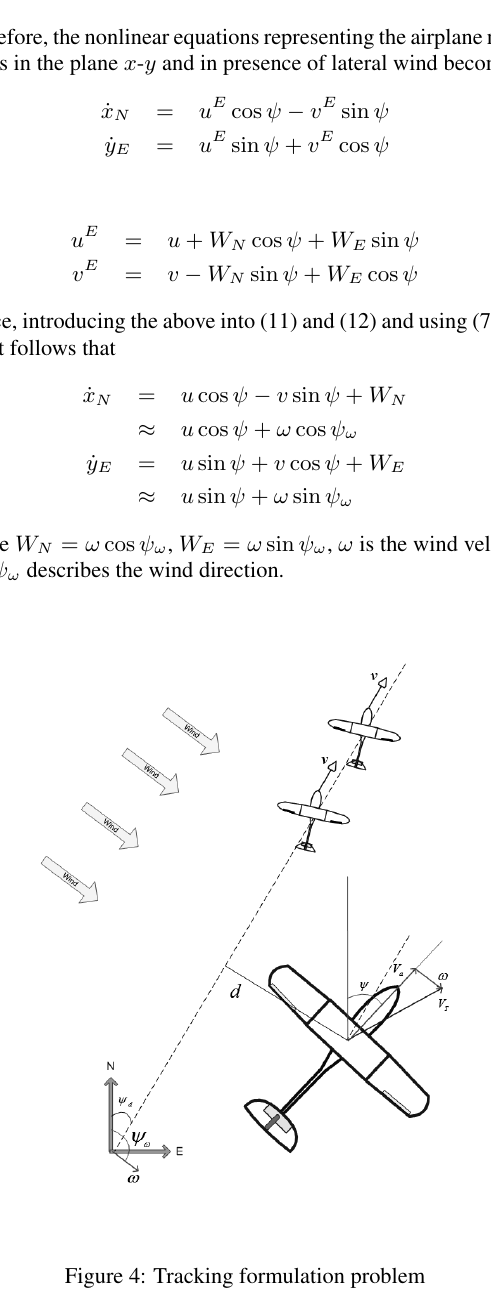
Figure 4: Tracking formulation